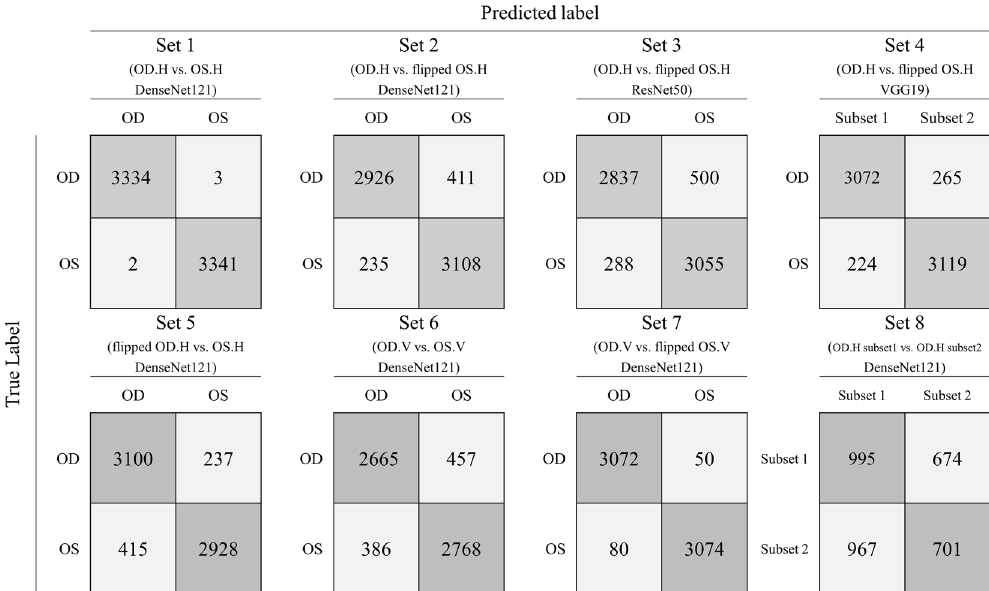
Figure 2. Confusion matrix for each test set. The classification accuracy for Set 1 was 99.93%, which was the highest among all sets. (AUC = 0.999, p < 0.001). Sets 2–5 showed test accuracies of ~ 90% (90.33%, 88.20%, 92.68%, and 90.24%, respectively; AUC: 0.902, 0.882, 0.927, and 0.902, respectively; all p values < 0.001). Set 6 showed a test accuracy of 86.57% (AUC = 0.866, p < 0.001). The accuracy of Set 7 was 97.93%, which was the second-highest (AUC = 0.979, p < 0.001). The results for Sets 1–7 were statistically significant. Set 8 showed 50.82% classification accuracy (AUC = 0.505, p = 0.548). OD oculus dexter, OS oculus sinister, H horizontal, V